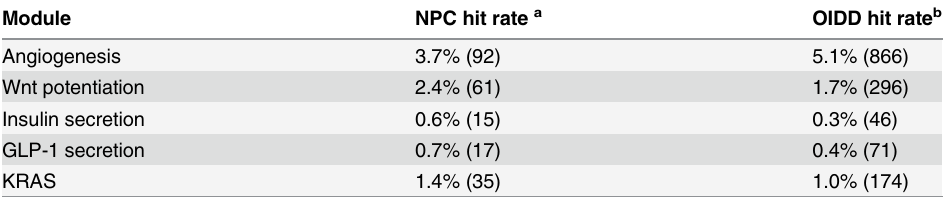
Table 1. Comparing OIDD phenotypic module hit rates obtained by screening NPC and OIDD com- pound collections. Module NPC hit rate a OIDD hit rate b Angiogenesis 3.7% (92) 5.1% (866) Wnt potentiation 2.4% (61) 1.7% (296) Insulin secretion 0.6% (15) 0.3% (46) GLP-1 secretion 0.7% (17) 0.4% (71) KRAS 1.4% (35) 1.0% (174) (cid:3) 5 μ M in the primary concentration- a the hit rate is the percent of 2,509 compounds screened having IC 50 response assays and meeting the selectivity criteria described in methods (e.g. reduction in tube area without cytotoxicity in the angiogenesis module).